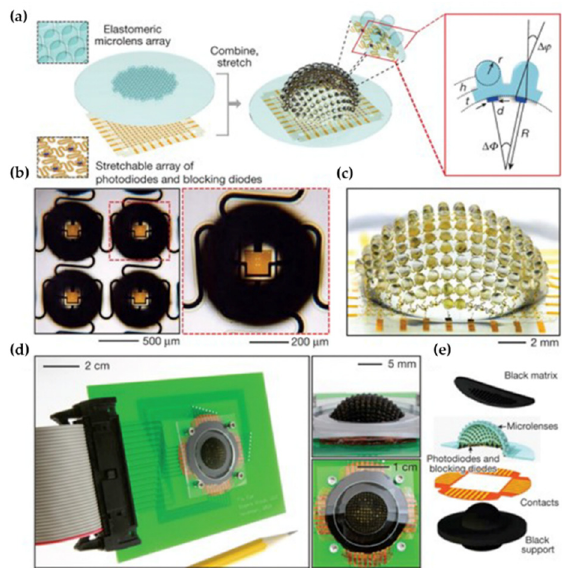
Figure 16 . ( a ) The structure of the arthopod-inspired camera. ( b ) The optical micrograph of four adjacent ommatidia. ( c ) The camera system after hemispherical deformation. ( d ) The completed camera mounted on a PCB. ( e ) The view illustration of the components of this system. Reproduced from [55] with permission from Springer Nature Publishing.